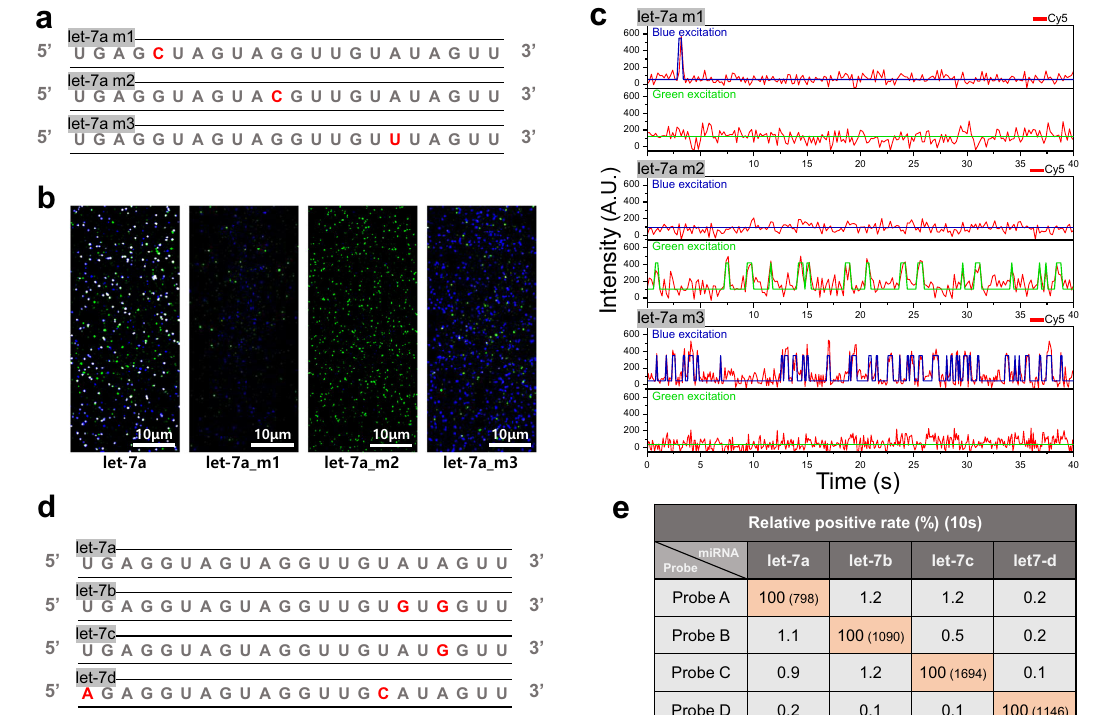
Fig. 2 Speci fi city of dynamic FRET-FISH. a Sequences of let-7a point mutants. Red letters indicate mutation sites. b Single-molecule images of wild type let-7a and its point mutants. To generate the images, the acceptor signal was accumulated for 60 s at Alexa-488 excitation (blue) and Cy3 excitation (green). Spots where blue and green colors overlap were colored in white. c Representative acceptor fl uorescence intensity time traces of let-7a point mutants. d Sequences of let-7 family miRNAs. Red letters indicate sequence variations from let-7a. e False positive rates of let-7 family miRNA detection. For the experiments, we immobilized 100 pM target miRNAs and injected the designated probe sets. Molecules were identi fi ed as a proper target miRNA if an acceptor (Cy5) fl uorescence signal occurs during the initial 10 s at both Alexa-488 and Cy3 excitations. The false positive rates were calculated by dividing the off-target number by the on-target number. The Numbers in parentheses are the total molecules that we analysed in the experiments.